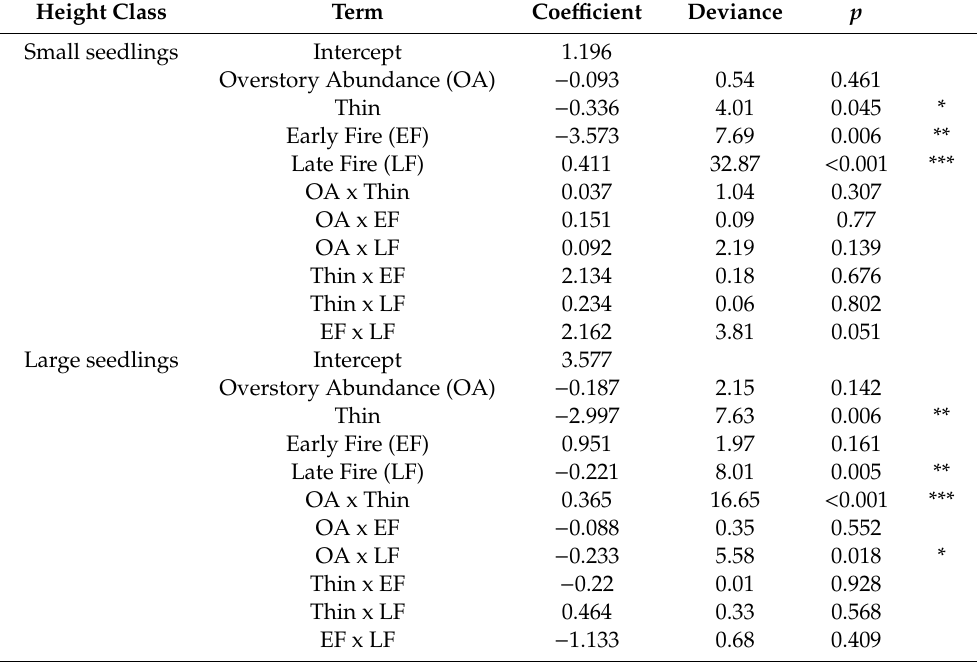
Table A6. Model results for regeneration frequency by height class on the Late sampling date ( n = 72 plots). Each response was analyzed with a GLM with a negative binomial distribution. The total deviance was 129.4 for small seedlings, 112.0 for large seedlings, and 105.6 for saplings. Coe ffi cients are not back-transformed to original units. Statistical significance was evaluated using a chi-square test of the deviance explained by the term ( df = 1 for all